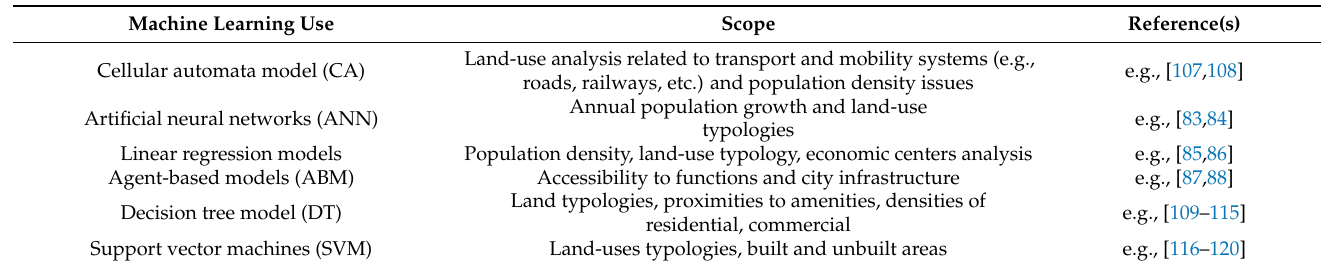
Table 3. Machine Learning use in land-uses strategies (adapted by Karimi et al.